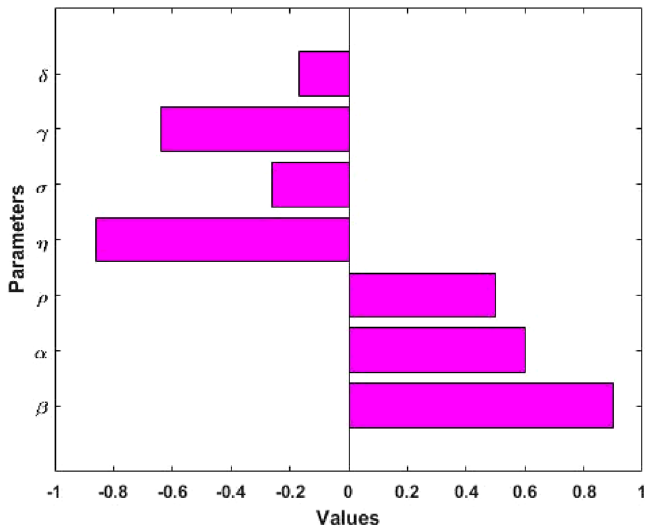
Figure 6. Correlation between measles prevalence ( I ∗ ) and the model parameters β , α , ρ , σ , γ , η and δ .